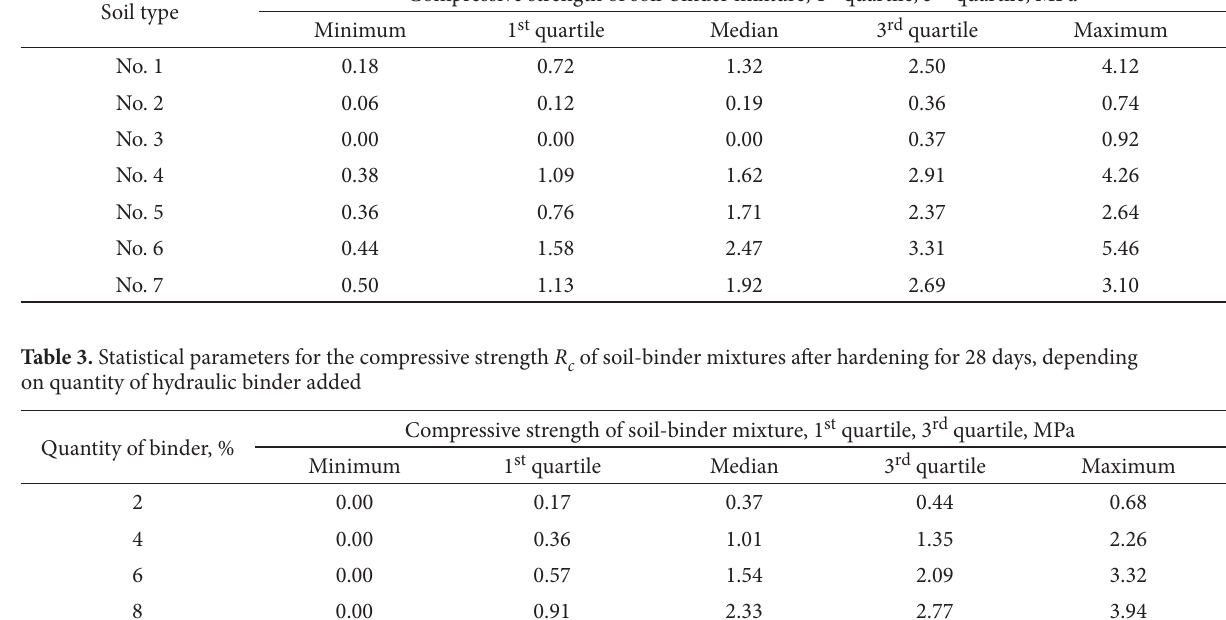
Table 2. Statistical parameters for the compressive strength R c of soil-binder mixtures after hardening for 28 days, depending on soil type Soil type